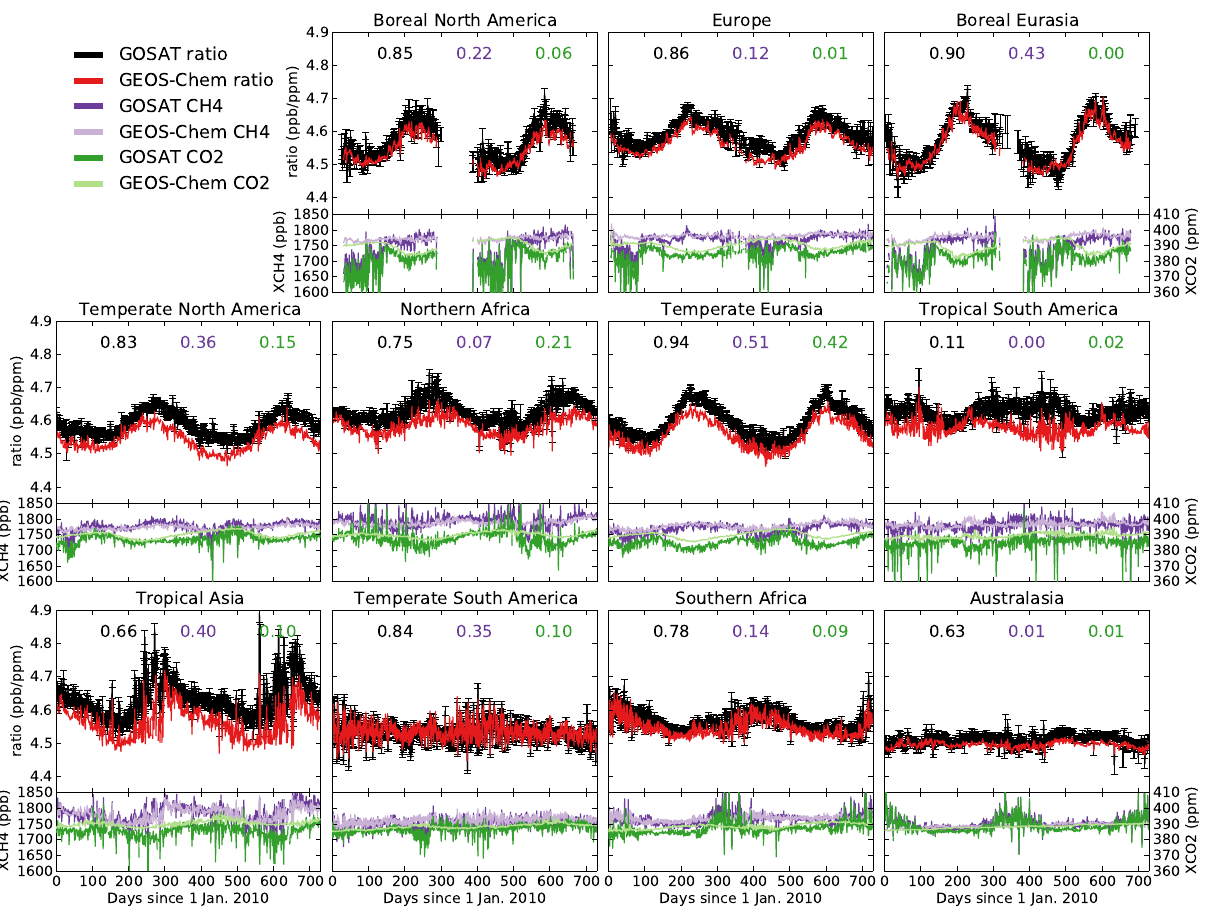
Figure 5. GOSAT and GEOS-Chem daily mean XCH 4 : XCO 2 ratios (top panels) for 2010–2011, averaged over each land region shown in Fig. 1. Squared Pearson correlation coefficients between GOSAT and GEOS-Chem are shown inset for the ratio (black), XCH 4 (purple), and XCO 2 (green). Bottom panels show the corresponding GOSAT and GEOS-Chem daily mean XCH 4 and XCO 2 . The model has been sampled at the time and location of the GOSAT observations, and convolved with scene-dependent averaging kernels.